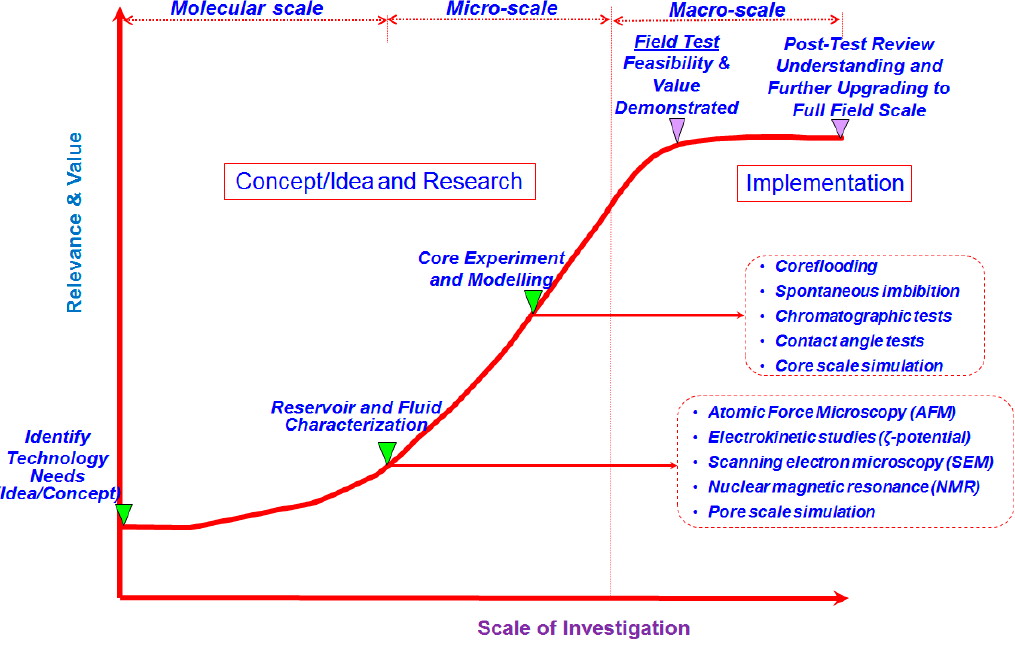
Figure 1. R&D-to-Field sketch of the systematic investigation for brine-dependent recovery design and implementation (adapted from Sarma [105]).